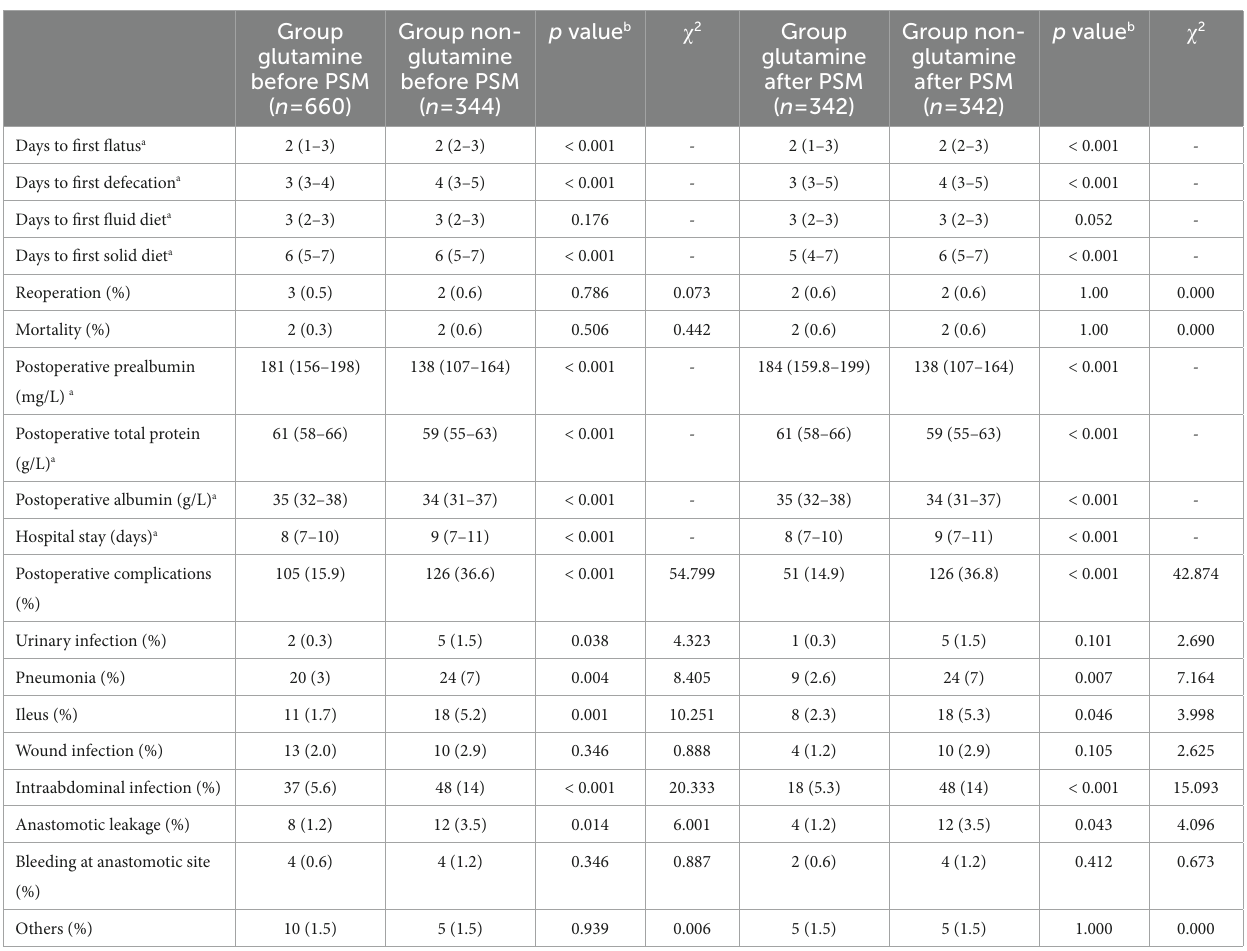
TABLE 2 Operative outcomes before and after propensity score